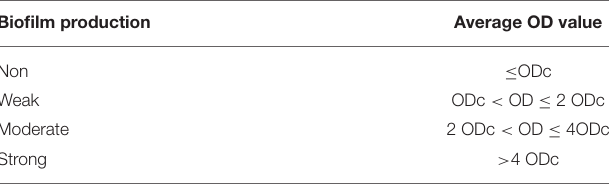
TABLE 1 | Interpretation of biofilm production. TABLE 2 | Sequences of PCR and RT-qPCR primers used in this